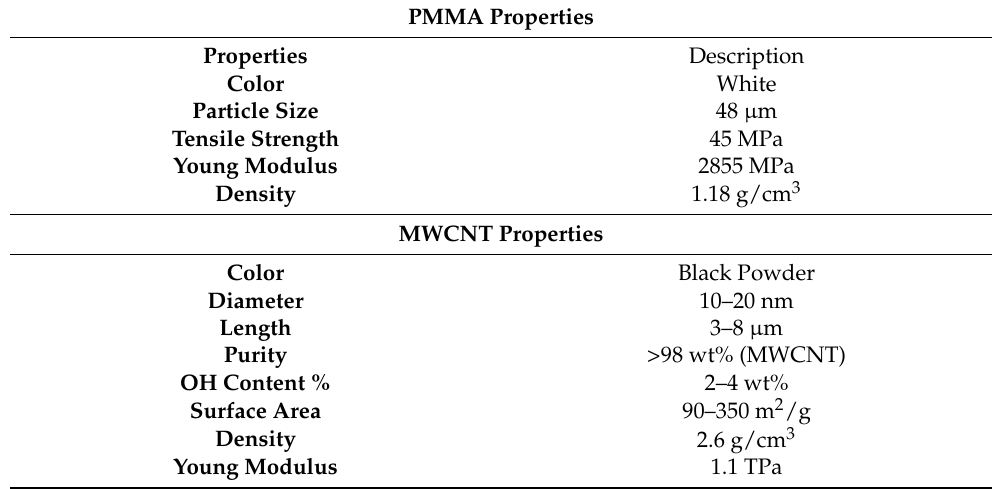
Table 1. PMMA and MWCNT Properties [Adapted from Ref.